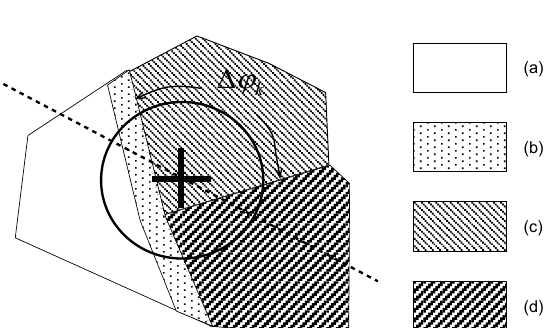
Fig. 2 Piecewise constant model of underlying surface (the plus sign denotes the position of nadir, the dotted line denotes the track of the satellite, the circle denotes the border of the illuminated area at a given time, (a) – the water, (b) – the slick and (c) and (d) – different types of land: swamp or